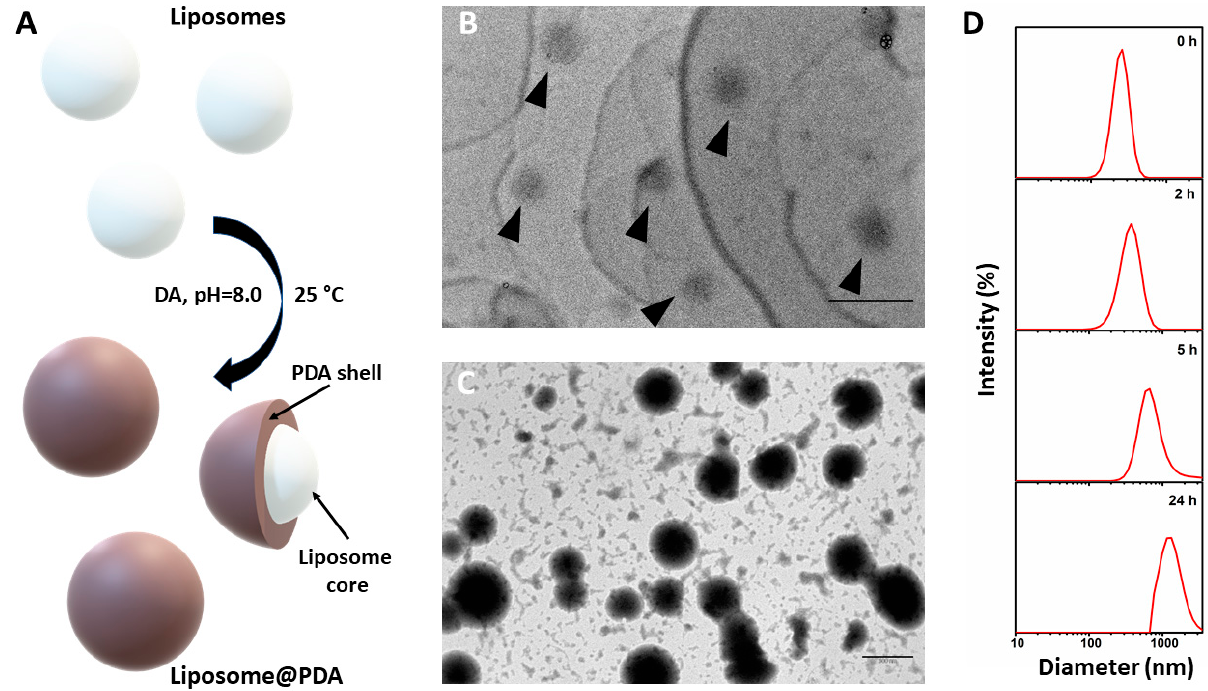
Figure 1. ( A ) Sketch of the Liposome@PDA microspheres preparation. (The schemes are not drawn to scale). TEM images of ( B ) as prepared liposomes (indicated by arrowheads, scale bar 500 nm) and ( C ) Liposome@PDA microspheres after 24 h of DA polymerization (scale bar 500 nm). ( D ) Hydrodynamic diameter of microspheres obtained by DLS measurements at diverse times of polymerization of DA.